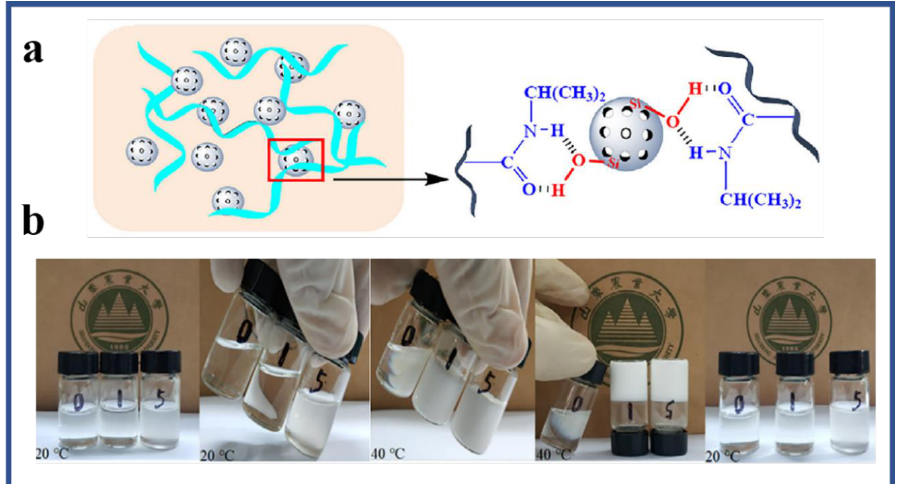
Figure 5. ( a ) Synthesis mechanism of poly (N-isopropylacrylamide) / mesoporous silica nanoparticle (PNIPAM / MSN) composite hydrogels; ( b ) digital photographs showing the PNIPAM / MSN-0, PNIPAM / MSN-1, and PNIPAM / MSN-5 hydrogels at 20 ◦ C and 40 ◦ C